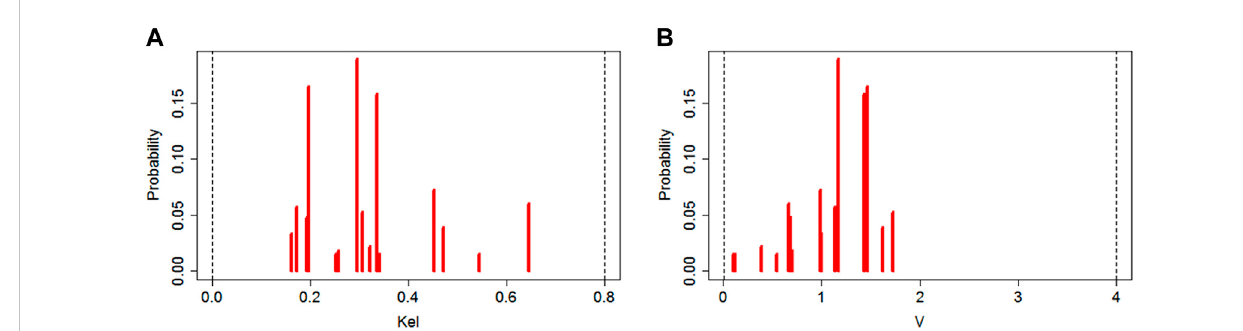
FIGURE 1 Plot of marginal fi nal cycle parameter value distributions for the linear one-compartment PK model (left side (A) — data for Kel; right side (B) — data for V).